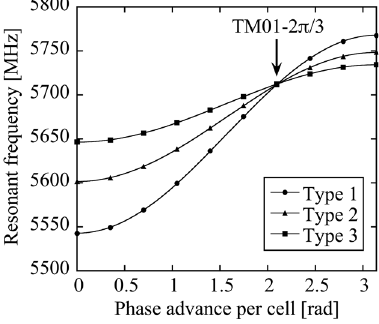
FIG. 5. Dispersion curves of the test cavities.